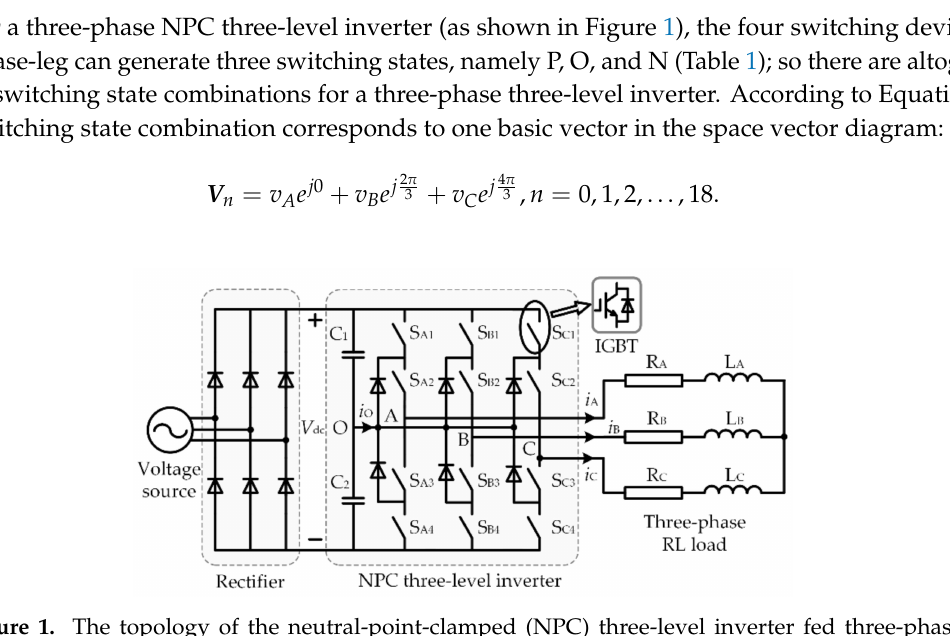
Figure 1. The topology of the neutral-point-clamped (NPC) three-level inverter fed three-phase